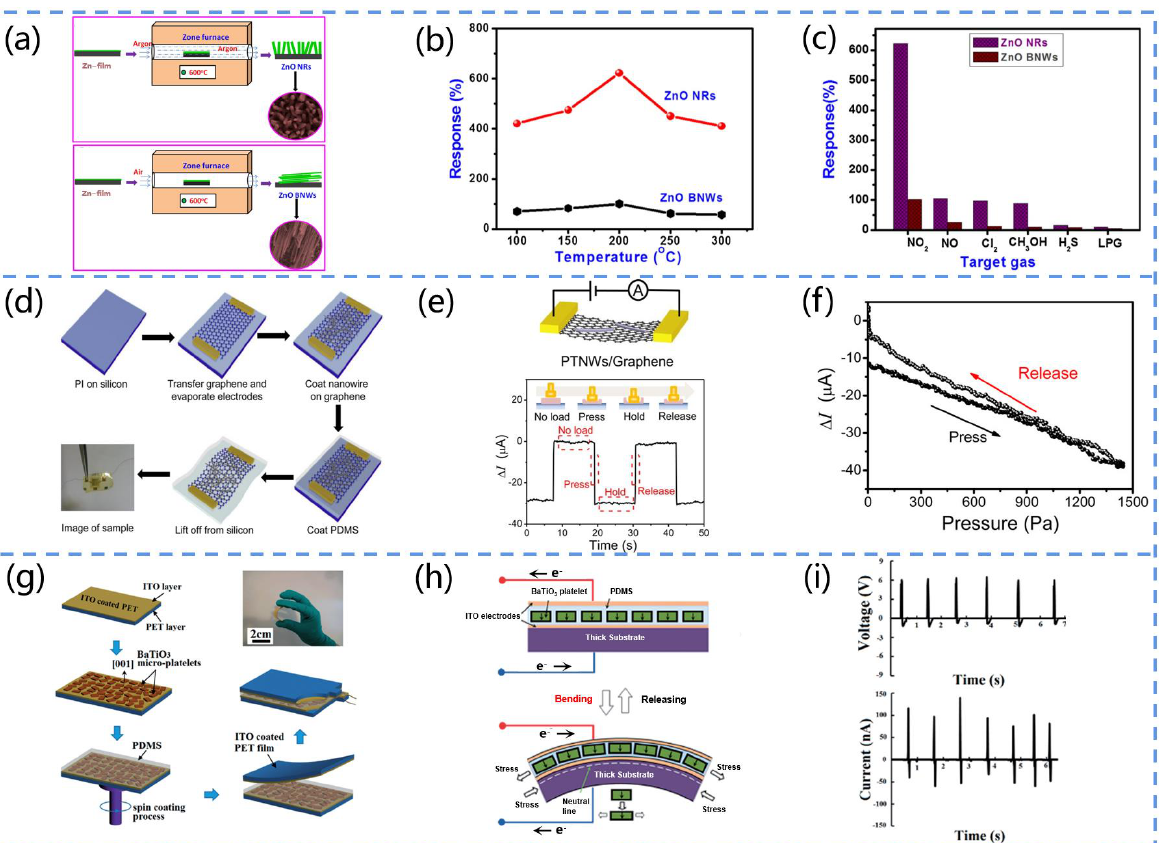
Figure 7. ( a ) Fabrication process of ZnO NR and ZnO BNW. ( b ) Responses of ZnO sensors at differ-